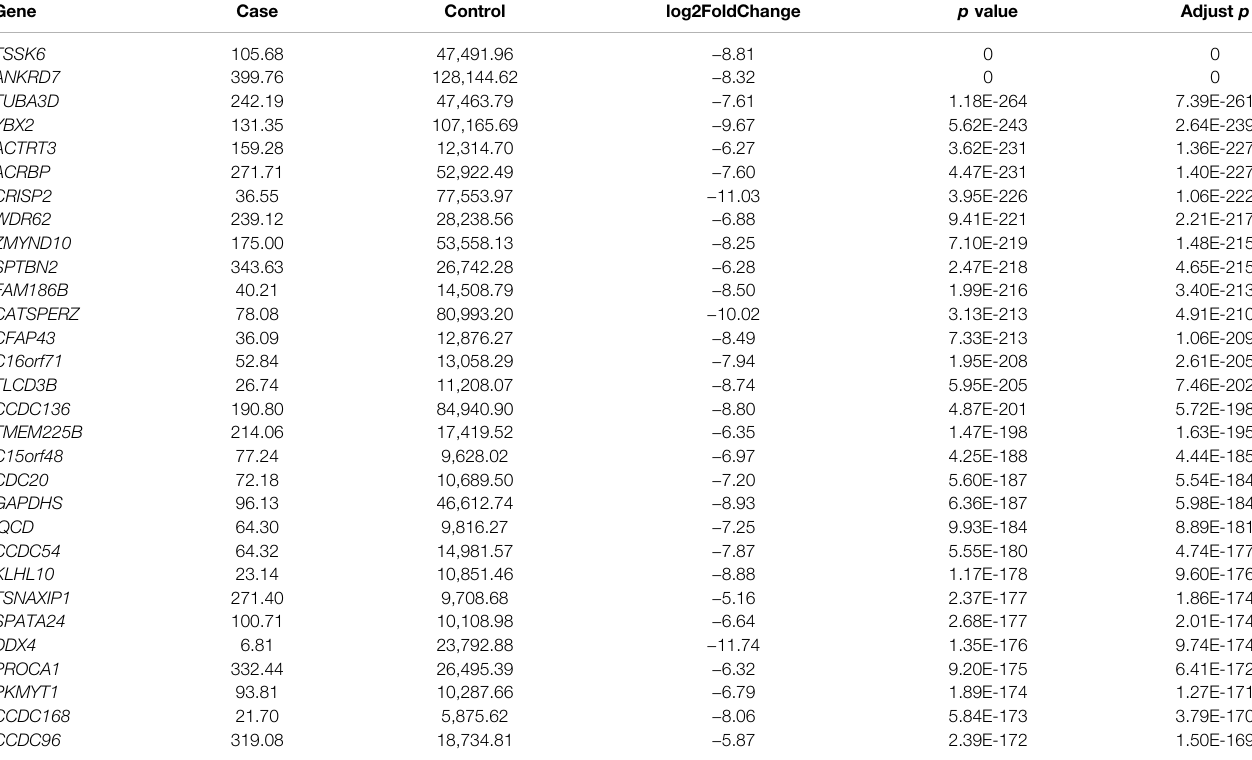
TABLE 4 | Top 30 most signi fi cantly downregulated genes in patients. Gene Case Control log2FoldChange p value Adjust p TSSK6 105.68